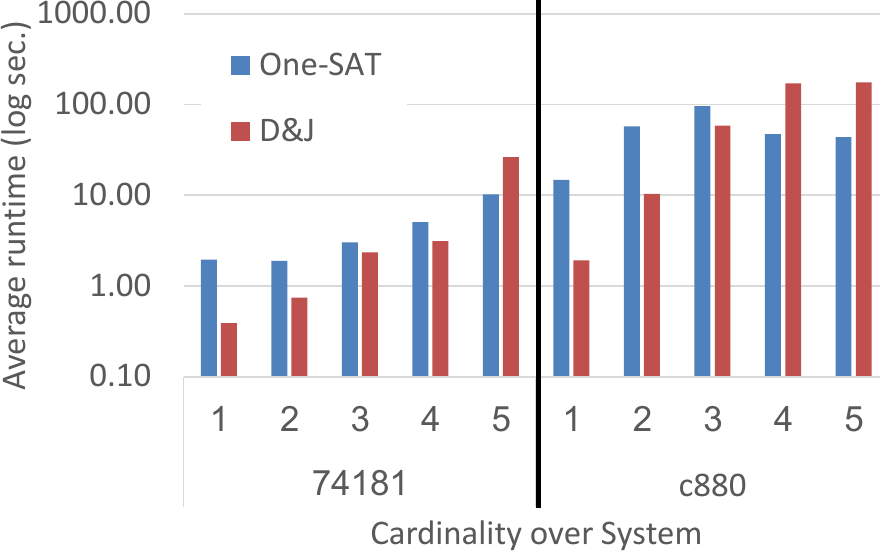
Figure 4. Runtime as a function of the MC